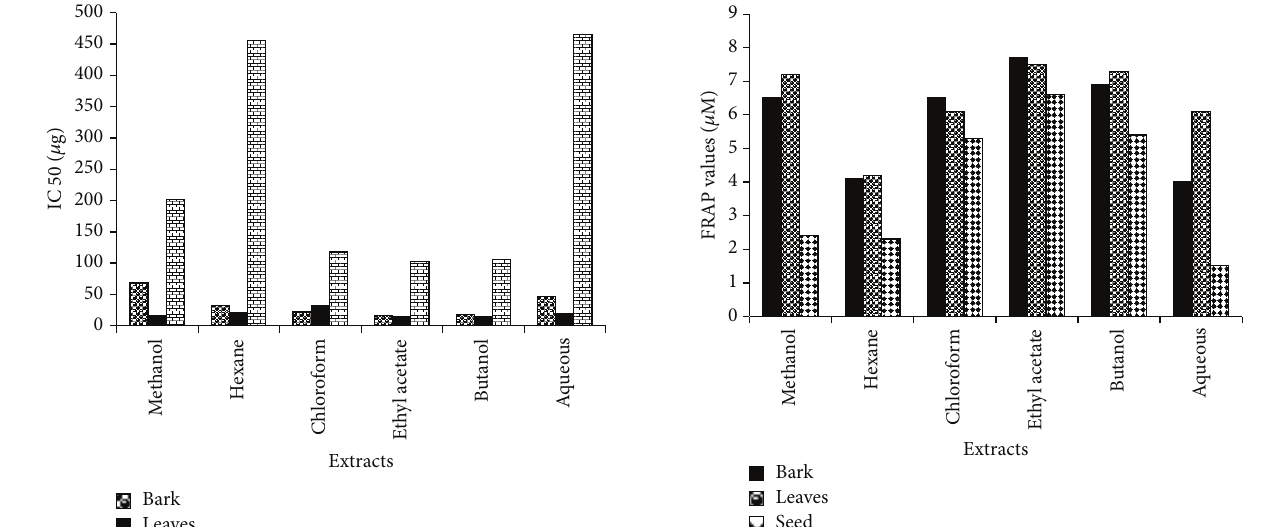
y = 0.2045x + 19.173 R 2 = 0.9506